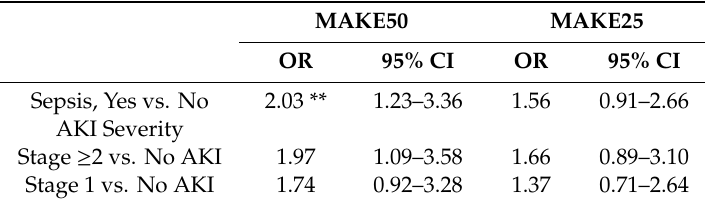
Table 4. Multivariable logistic regression models of major adverse kidney events as the dependent variable and relevant clinical parameters as the independent variables.